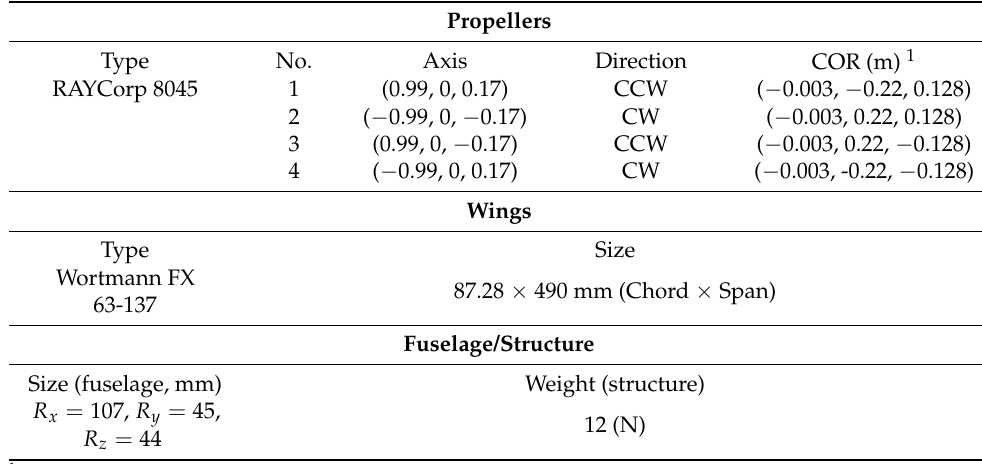
Figure 1. Geometry of CRC-3: ( a ) isometric view; ( b ) side view. The elliptical fuselage has principle diameters of 0.214 m, 0.09 m, and 0.09 m in x , y , and z directions, respectively. The main geometrical parameters of CRC-3 are listed in Table 1. Table 1. The main parameters of